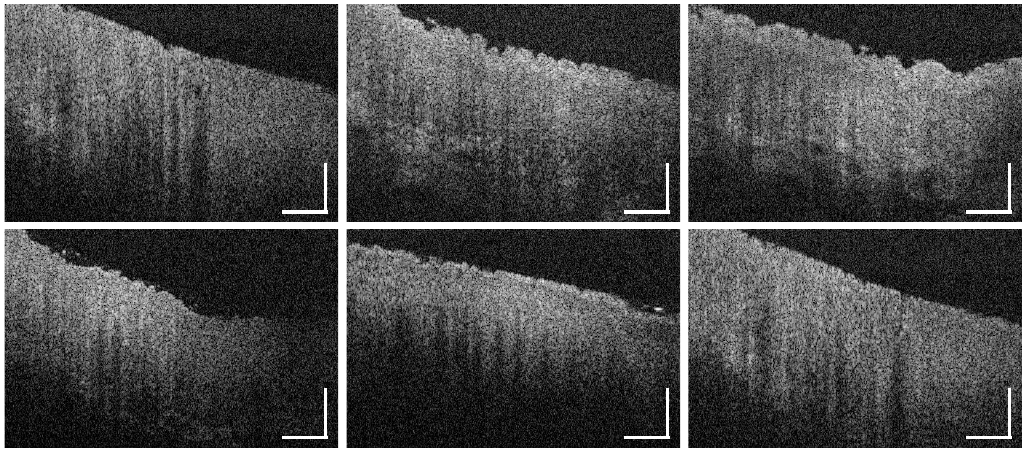
Figure A18. Supplementary intensity-based OCT cross sections of the buccal mucosa of the posterior inner cheek (MP8, Figure 1). Scale bars: 200 µ m.